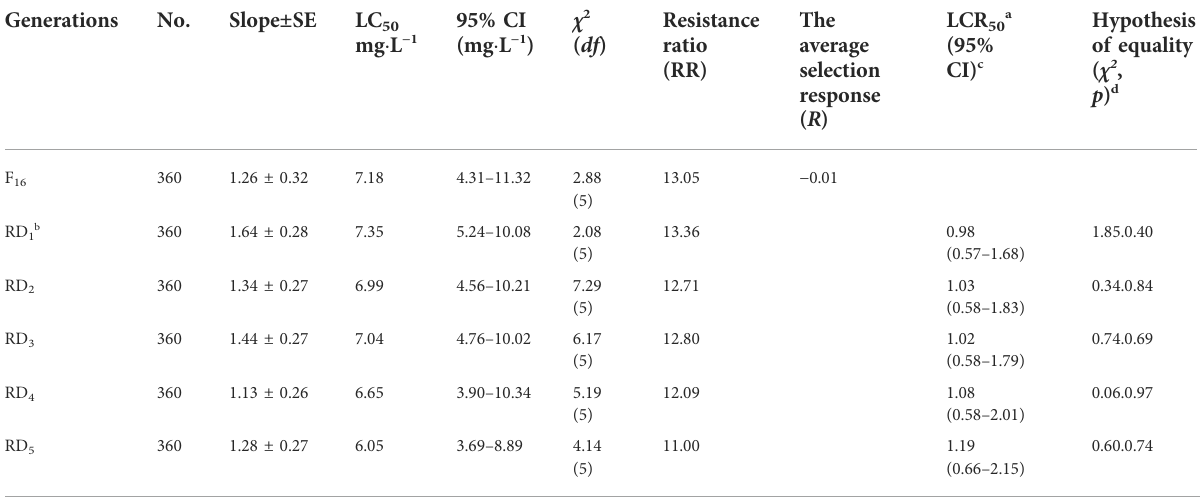
TABLE 3 The resistance stability of RS strain of SBPH without TFM. Generations